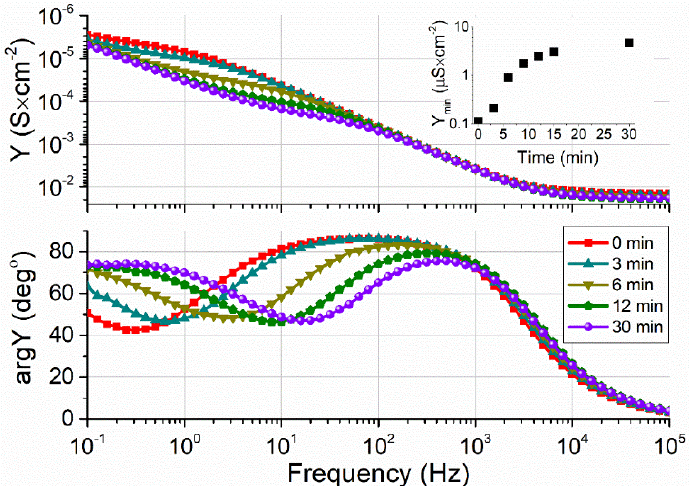
Figure 8. EIS spectral transformations of tBLMs upon exposure to VLY on time (initial, 3 min, 6 min, 9 min, 30 min). Admittance modulus (upper panel) and phase (lower panel) (Bode) plots. Inset shows admittance values at phase minimum (f min ) point as a function of time. Two-nanometer VLY kinetics on tBLM were formed on mixed WC14/3M1P SAM and completed with DOPC/Chol (in molar ratio 6:4) phospholipid